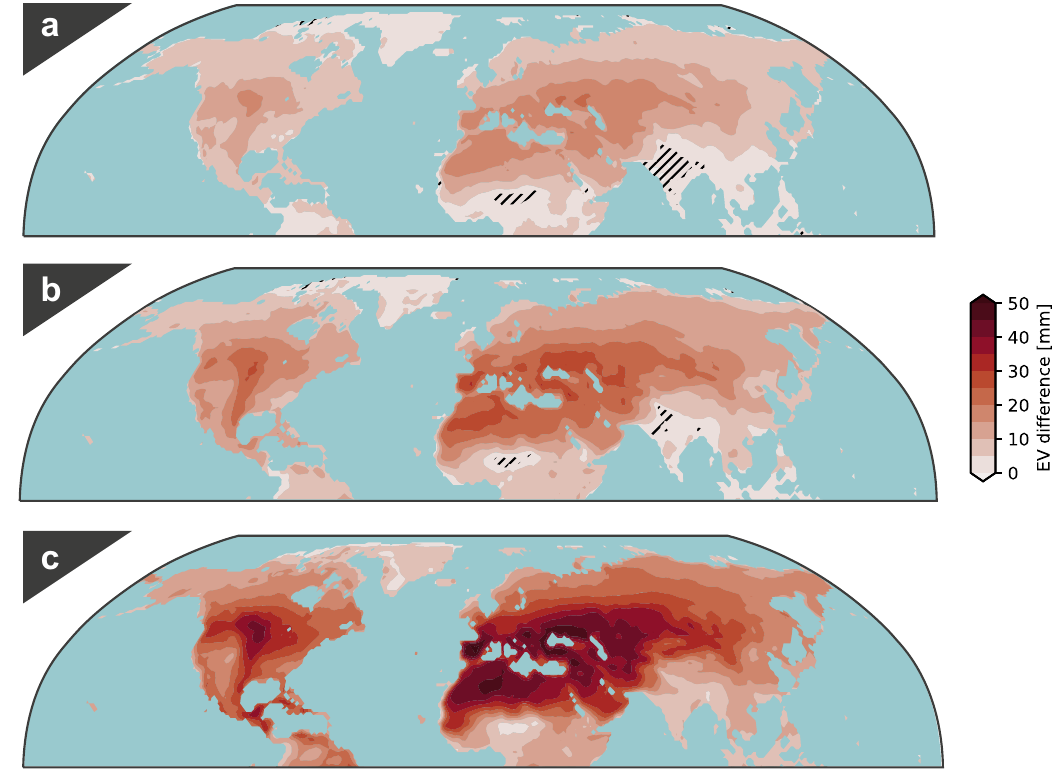
Fig. 5 Changes to summer potential evapotranspiration under SSP1-2.6, SSP2-4.5 and SSP5-8.5. a – c Averaged anomalies of summer potential evapotranspiration under SSP1-2.6 ( a ) and SSP2-4.5 ( b ) and SSP5-8.5 ( c ) in the Northern Hemisphere for the period 2071 – 2100 relative to the baseline period of 1971 – 2000. The hatched areas in all three sub fi gures indicate areas with insigni fi cant changes according to the two-sided Student ’ s t test ( p <